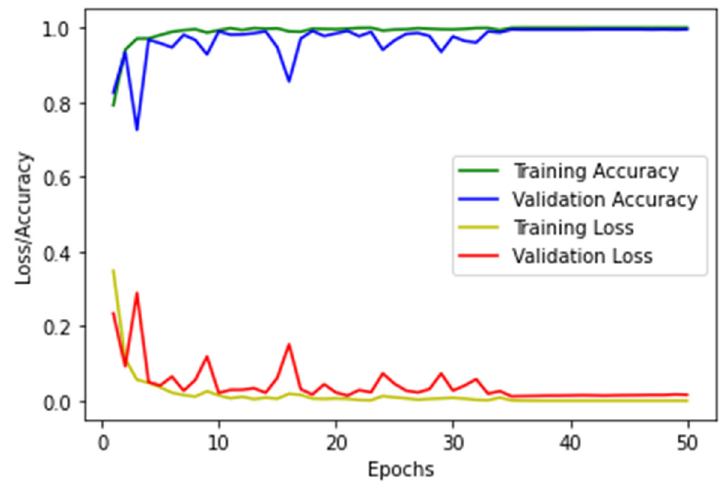
Figure 9. Training and validation progress of ResNet50.